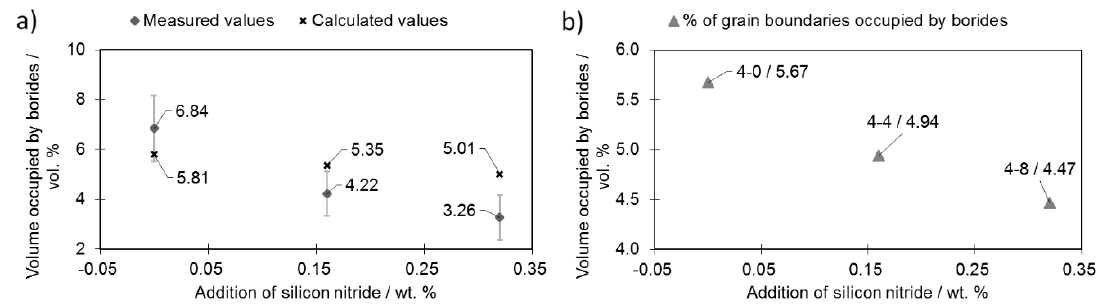
Figure 7. Influence of Si 3 N 4 addition on the ( a ) amount of borides and ( b ) percentage of grain surface occupied by borides. Data are for selected representative samples with 0.4 wt% boron addition.